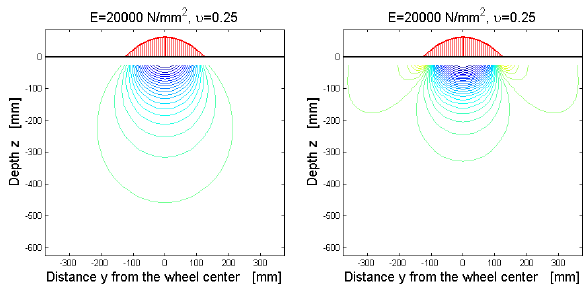
Figure 18: σ z contours on the A-A vertical cross-section of Figure 17: Boussinesq’s solution on the left and the second order solution on the right.